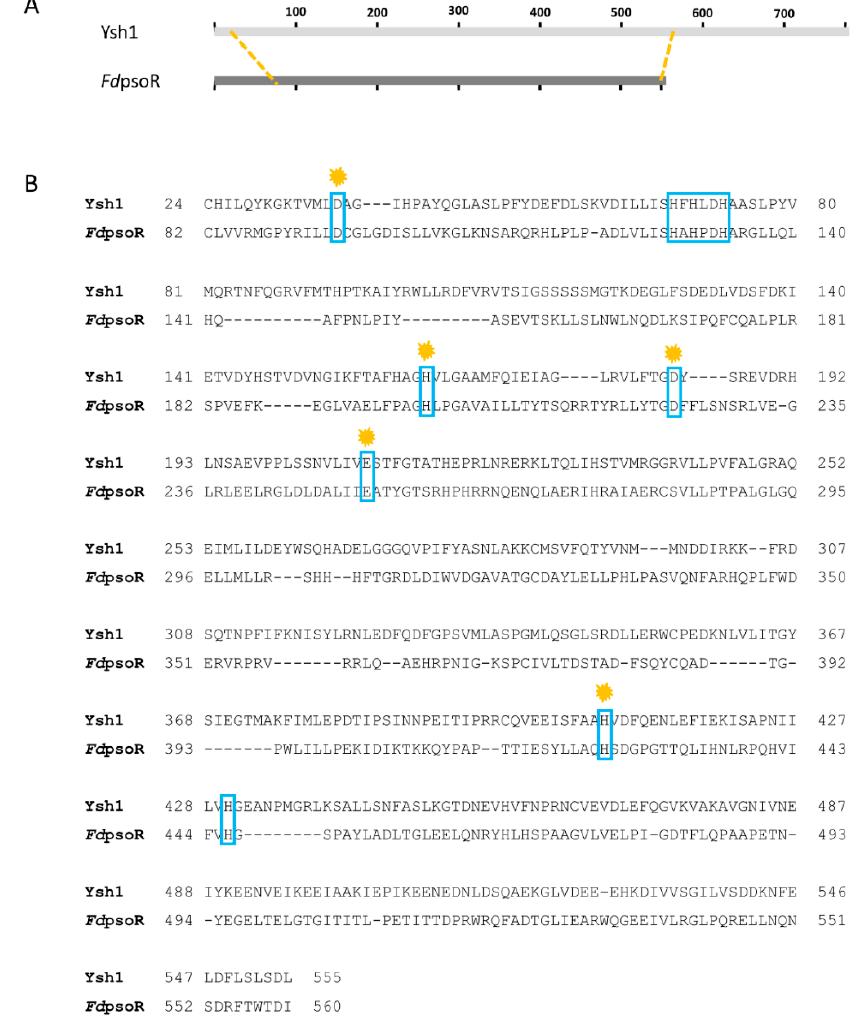
Figure 3. Sequence alignment of Fremyella diplosiphon PsoR ( Fd PsoR) with mRNA endonuclease Ysh1 from Saccharomyces cerevisiae . Amino acid sequence alignment with Fd PsoR and the mRNA endonuclease Ysh1 from S. cerevisiae using the NCBI Protein BLAST program: ( A ) Schematic showing the overall location of homology between Fd PsoR and Ysh1. Orange dashed lines indicate where homology begins and ends. ( B ) Amino acid alignment of homologous regions between Ysh1 and Fd PsoR. Blue boxes indicate conserved residues found in the seven motifs present in β -CASP proteins. Orange marks indicate areas where point mutations in Ysh1 resulted in a loss of endonuclease activity